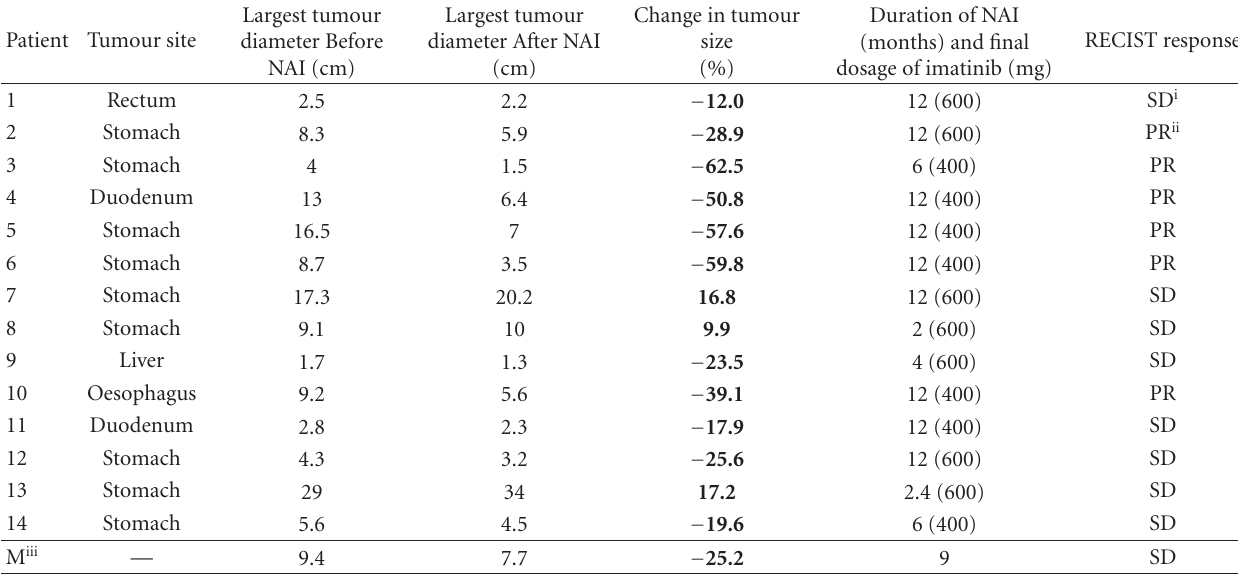
Table 2: Response to neoadjuvant imatinib (NAI).